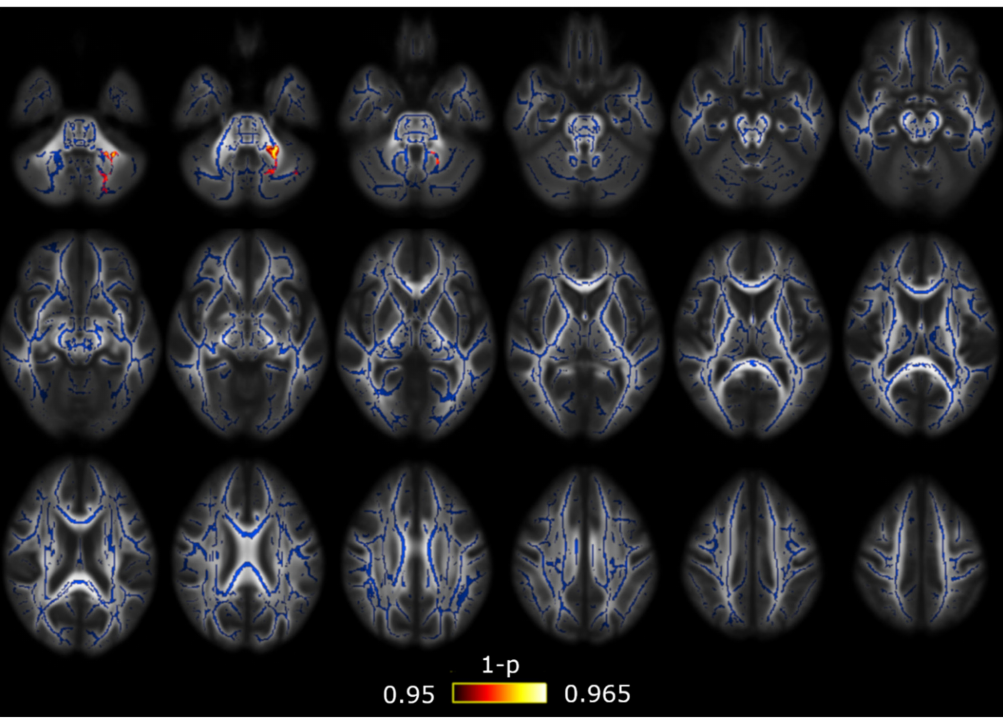
Figure 3. Return-to-plane (RTPP) alterations in patients with CM in comparison with patients with EM. Significant higher RTPP values in CM were found only in the middle cerebellar peduncle. The white matter skeleton is shown in blue and voxels with significant di ff erences in red-yellow. The color bar shows the 1-p values (family-wise error corrected).